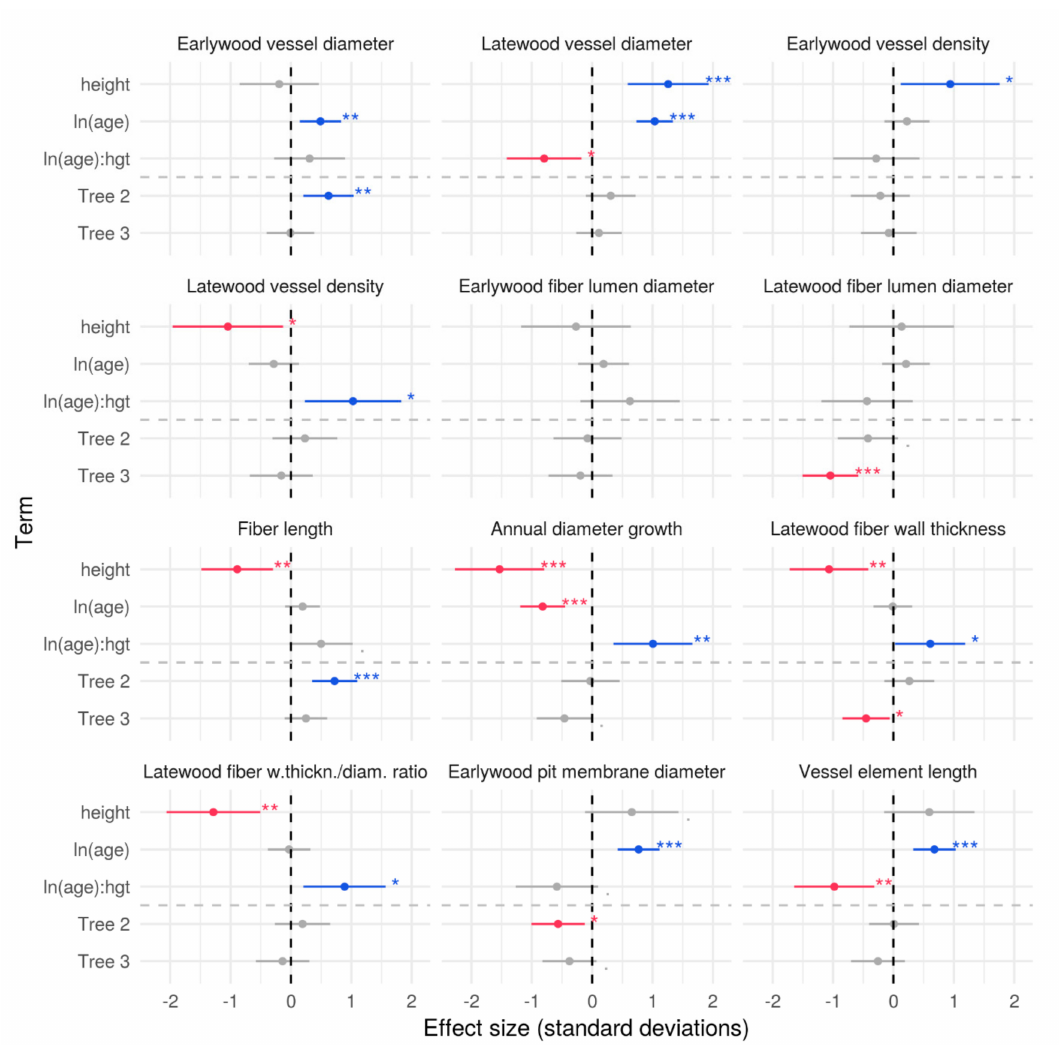
Figure 4. E ff ects sizes of the fitted linear models with their corresponding 95% confidence intervals. The change in standard deviations of the response when increasing the predictor by one standard deviation (for continuous predictor variables) or the di ff erence between factor levels in standard deviations of the response (for tree e ff ects) is shown. Blue: positive e ff ects, red: negative e ff ects, grey: insignificant e ff ects. Stars show significance levels (*, p < 0.05; **, p < 0.01; ***, p < 0.001). Note that Tree 1 does not appear in the table as it is included in the intercept term (not shown here as the scaled intercept is not relevant in terms of e ff ect sizes). The black dashed vertical line is at zero and indicates no e ff ect, and the horizontal dashed line is used to separate the e ff ects from individual tree e ff ects. Abbreviations: ln(age), natural logarithms of cambial age; hgt, axial